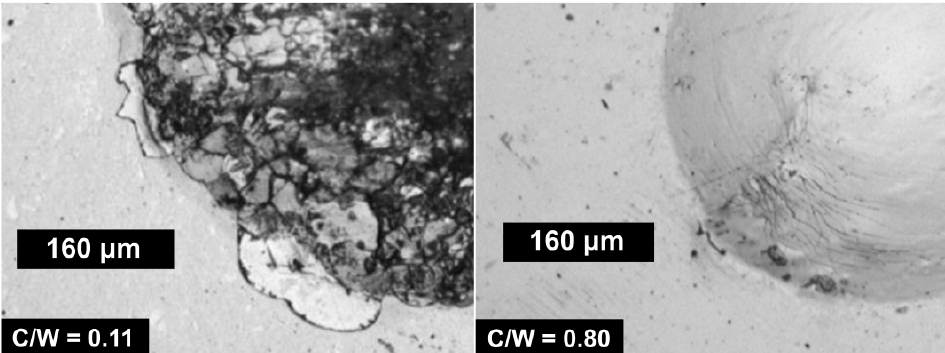
Figure 3. Detail view on the edges of impact craters created with load of 400 N and 10 000